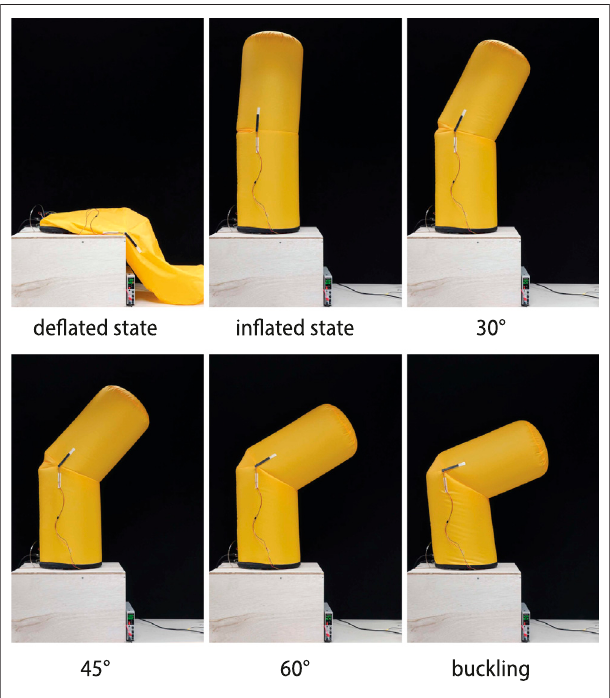
FIGURE 2 | Motion sequence of an in fl atable joint: de fl ated, in fl ated, fl exion, and buckling.